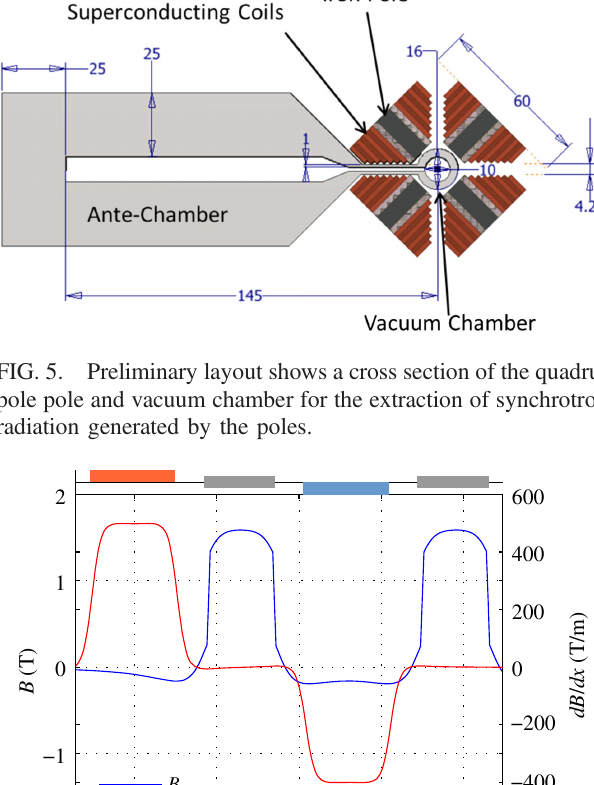
FIG. 6. Magnetic field calculations for a single cell of the complex bend.